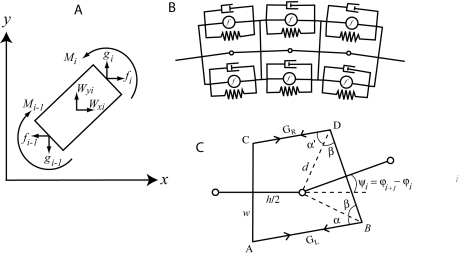
Forces and moments acting on link i (A), bending moments are determined by muscles on both sides of the body modeled by springs and dashpots with additional active elements (B), and forces and moments associated with a single joint (C).